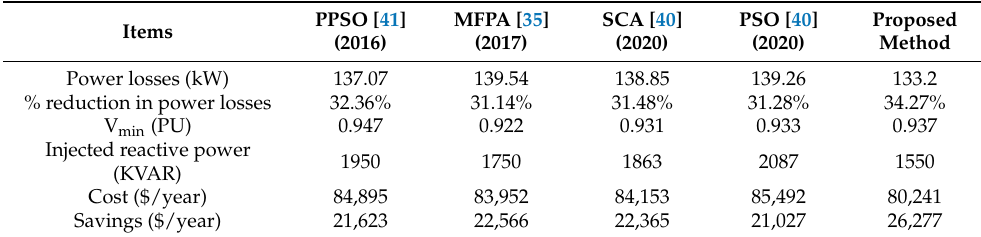
Table 5. IEEE 33 system with capacitor allocation only.